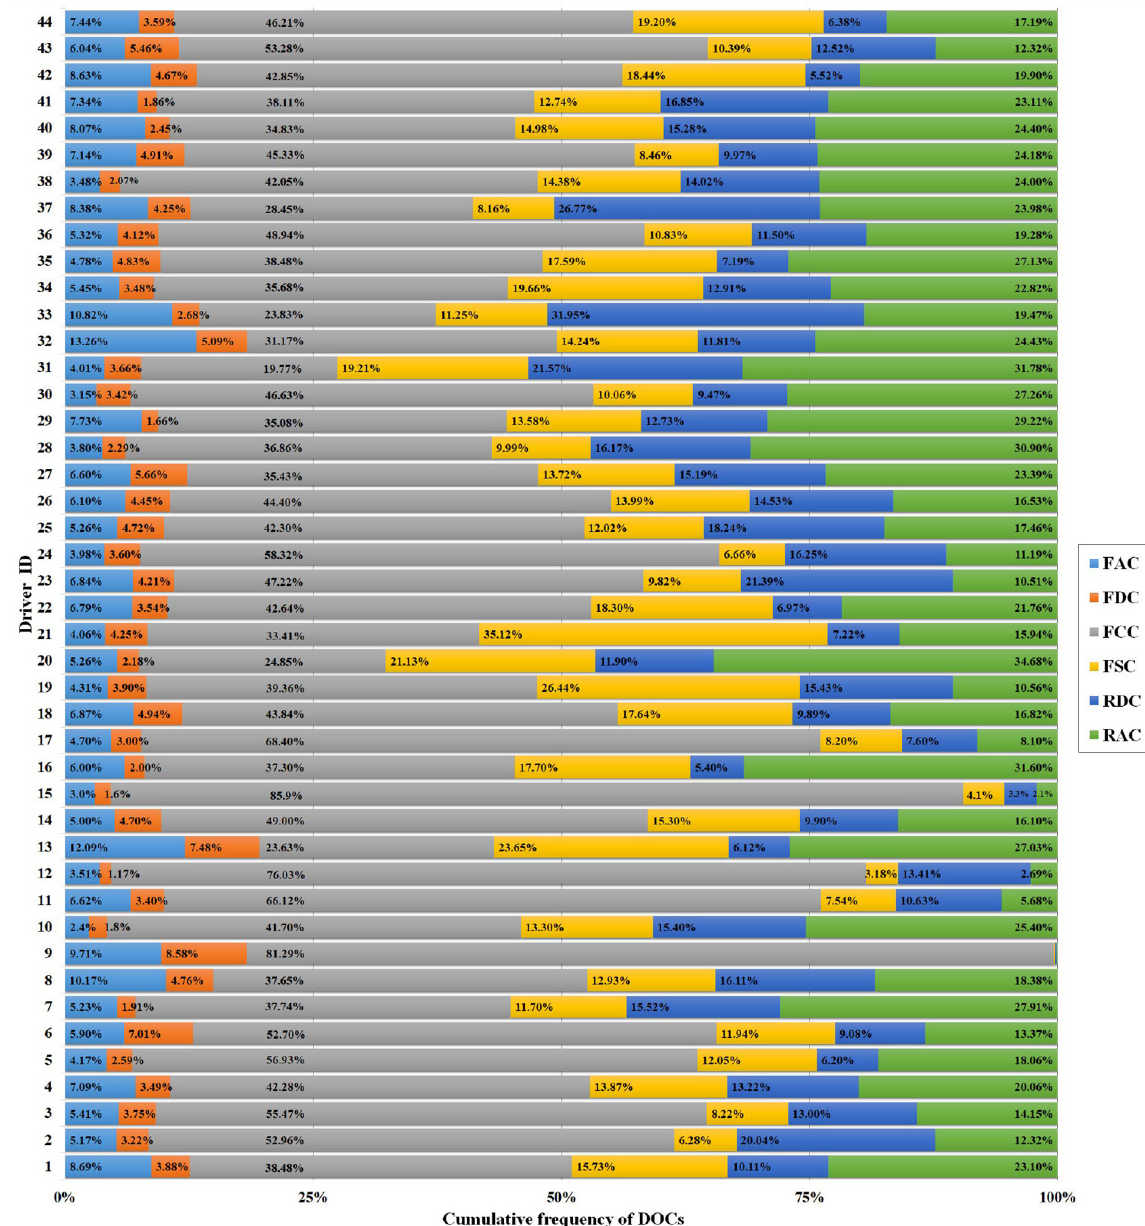
Figure 10 Frequency cumulative distribution of different DOCs